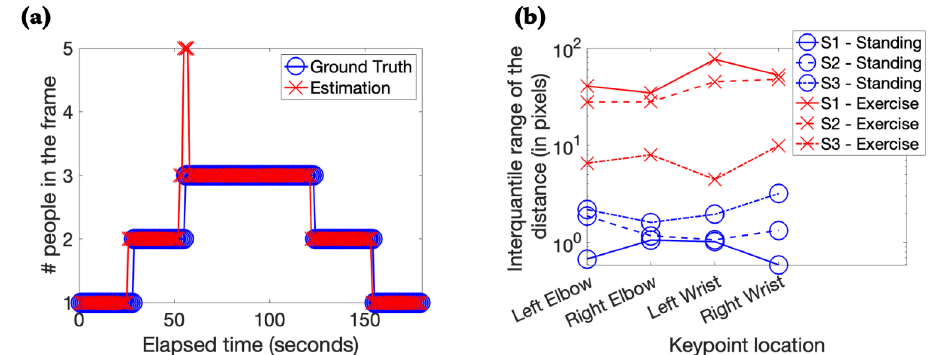
Figure 3. Results for occupancy estimation and activity phenotyping. ( a ) The comparison between the ground truth and the estimation by the algorithm for the number of people in each video frame is shown. ( b ) We show the interquartile range of the distance (in pixels) between the keypoints from consecutive frames (sampling frequency = 1 Hz) for three subjects standing and performing exercise. Table 5. A comparison of existing systems for non-contact human monitoring with our methods [KNN: K-Nearest Neighbour; RGB: Red-Green-Blue; RNN: Recurrent Neural Networks; DNN: Deep Neural Network; CNN: Convolutional Neural Networks; NA: Not Available; BLE: Bluetooth Low Energy; RO-EKF-SLAM: Range-Only Extended Kalman Filter Simultaneous Localization and Mapping; IMU: Inertial Measurement